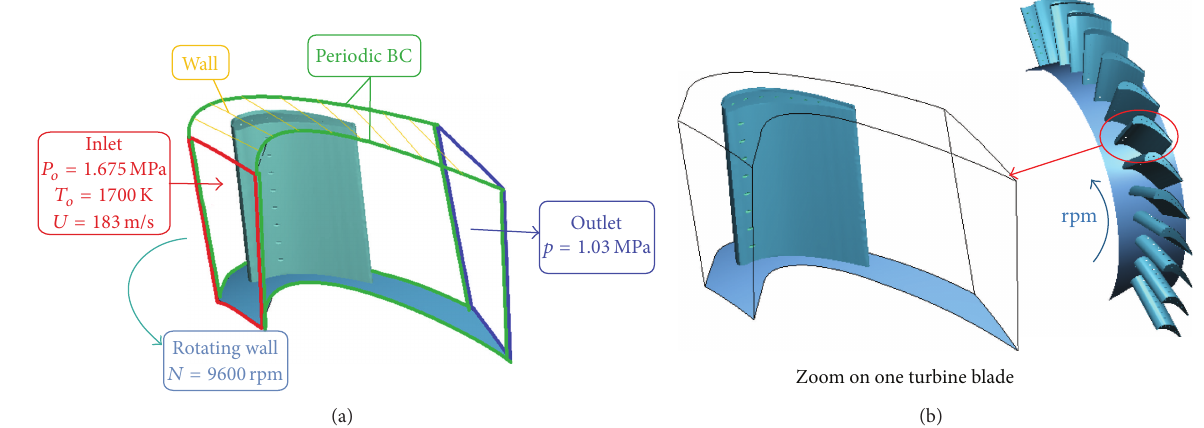
Figure 34: Turbine blade computational domain and boundary conditions.